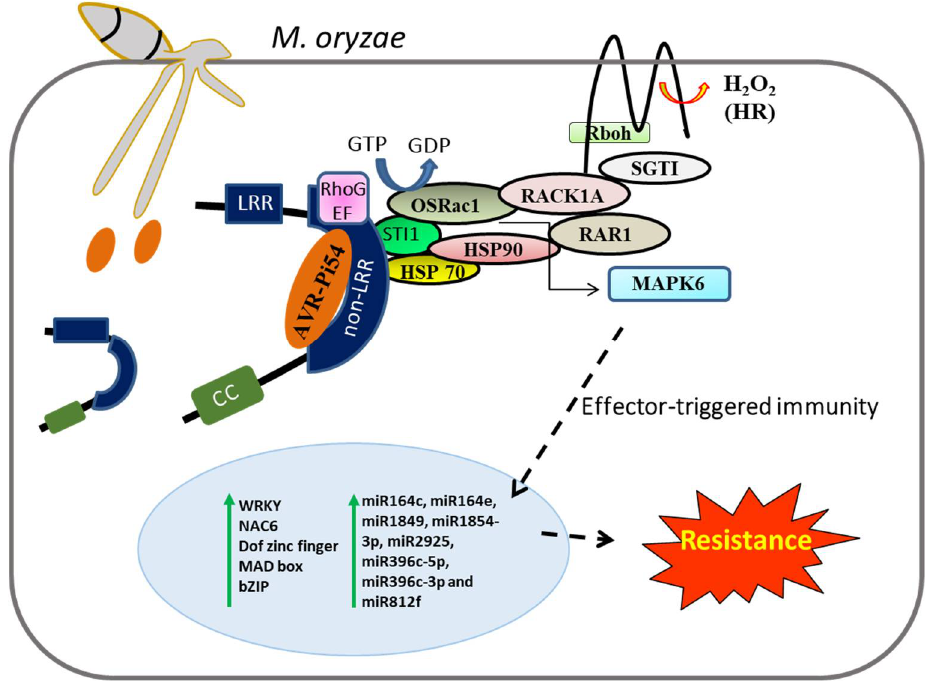
Figure 2. Schematic presentation of mechanisms of Pi54 locus-mediated blast disease resistance. The Avr-Pi54 effector binds to Pi54 and its orthologs (blue) mainly at the non-LRR region, upstream to the LRR domain. The Pi54 loci perceive the M. oryzae signals through STI1, an anchor for defensome complex involving multiple proteins such as OsRac1 (Rac/Rop GTPase), RACK1A (Receptor of Activated C Kinase), RAR (Required for Mla12 Resistance), SGT1 (Suppressor of the G2 allele of skp1), MAPK6 (a rice Mitogen-Activated Protein Kinase), and Rboh (NADPH oxidases). The MAPK6-mediated downstream signaling pathways might induce various DR genes. Besides, a set of miRNAs induced by the Pi54 loci are playing a role disease-resistance response. This figure is partially adapted and modified with the latest information [89].